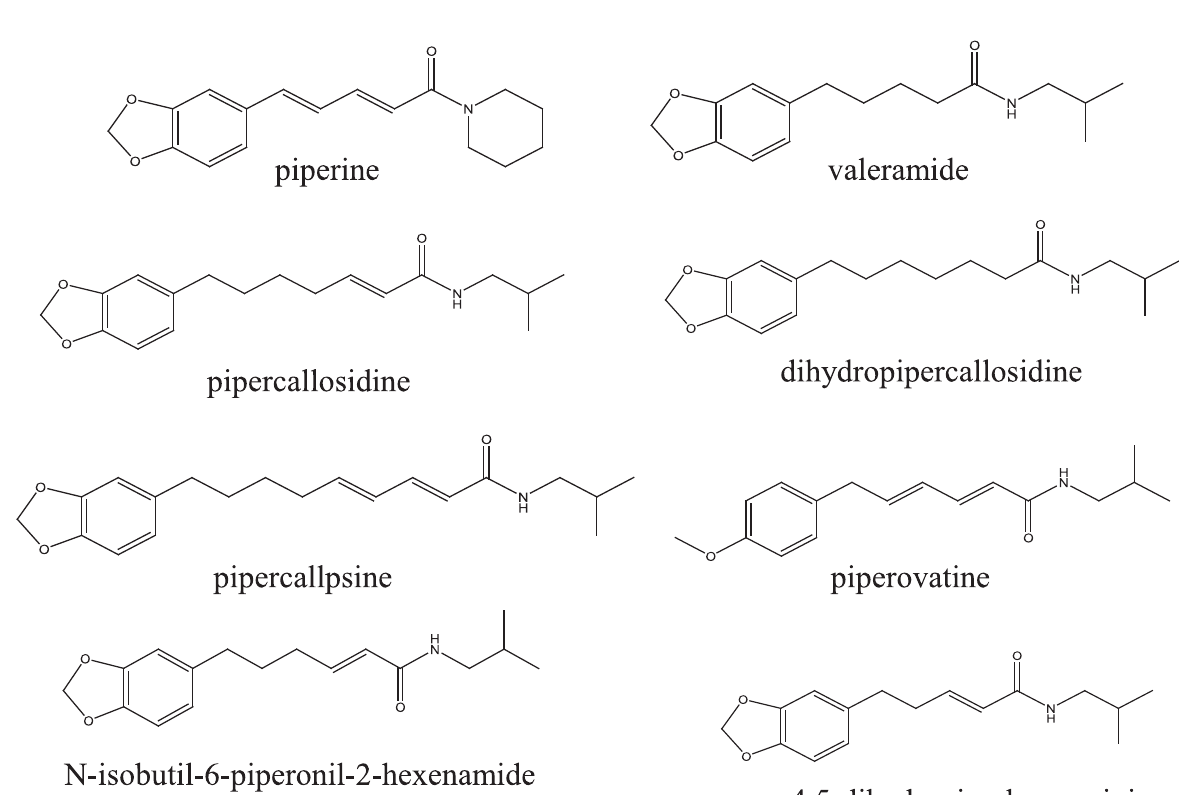
Figure 1 - Characterized amides from roots of O. anisum